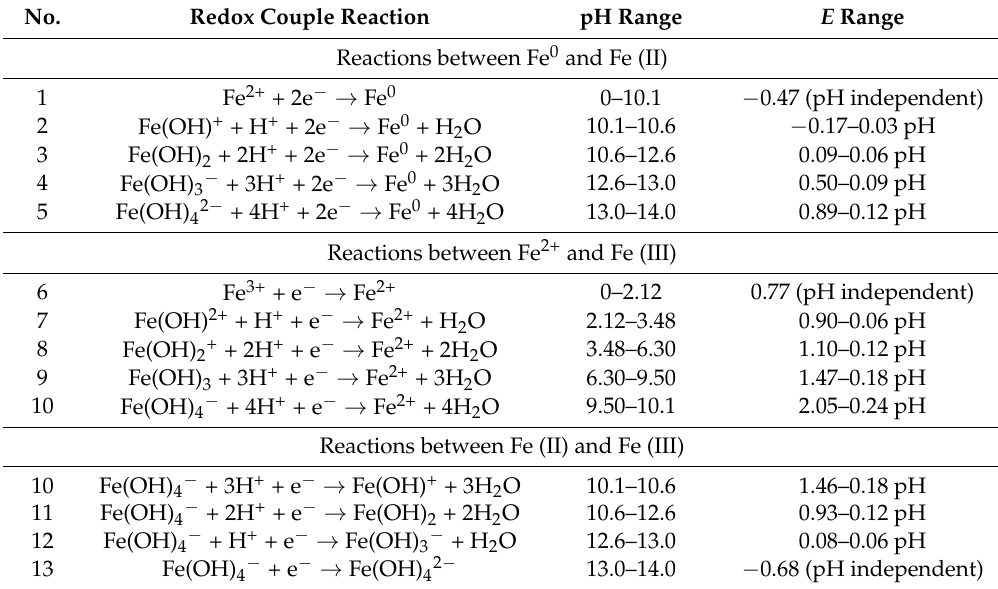
Table 4. Electrochemical potentials required for redox reactions ( E ) for Fe species corresponding to speciation diagrams [54,66–70]